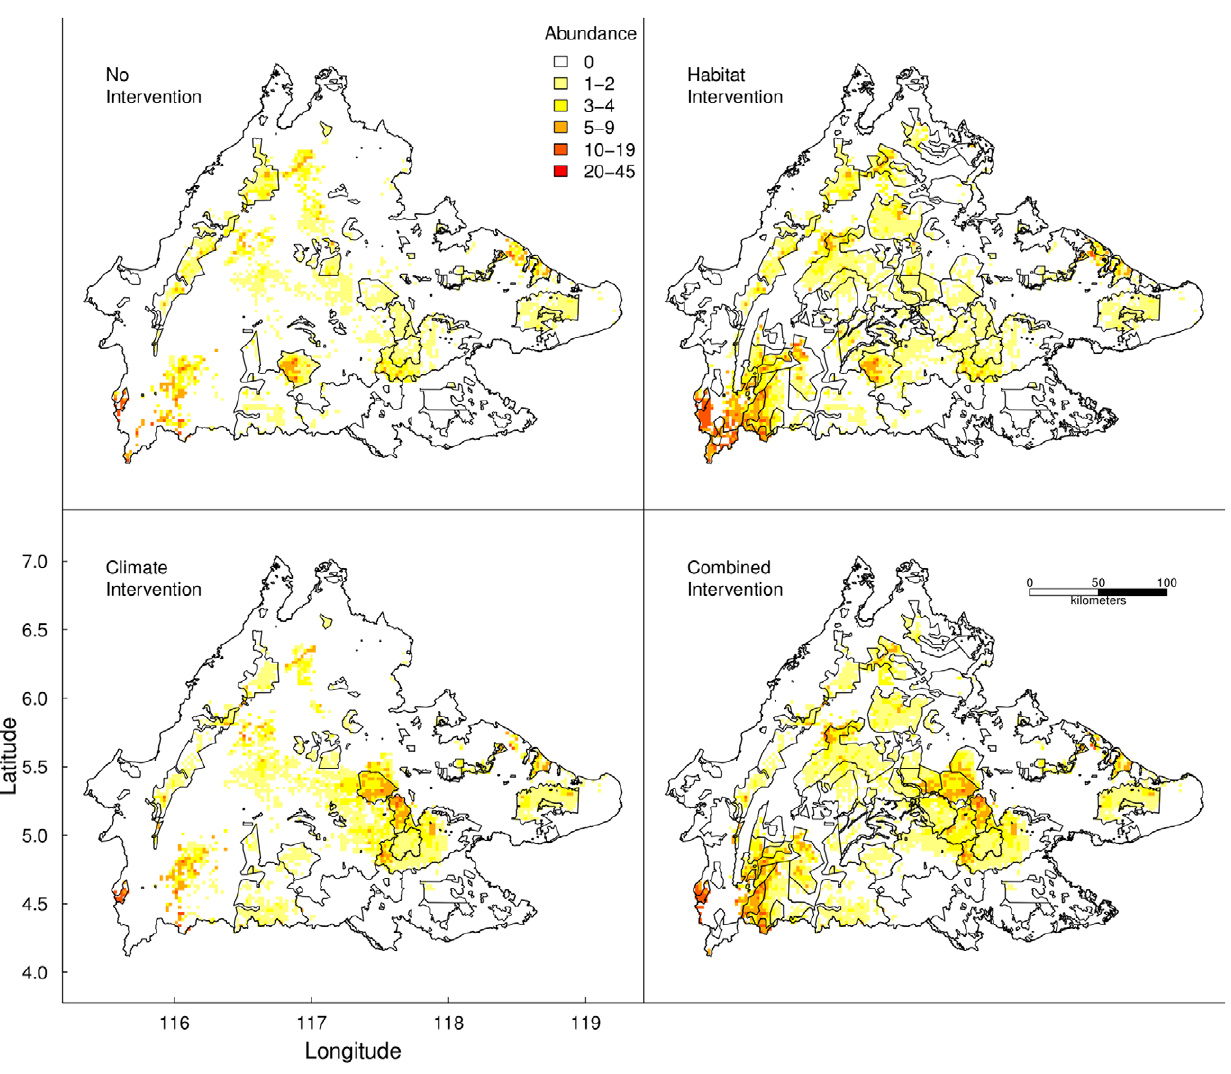
Figure 5. Spatial orangutan abundance in 2100 under the four intervention scenarios. Maps showing 2100 abundance projections for each intervention scenario described in Table 2. The polygons are the sustainably managed forest reserves under each scenario.